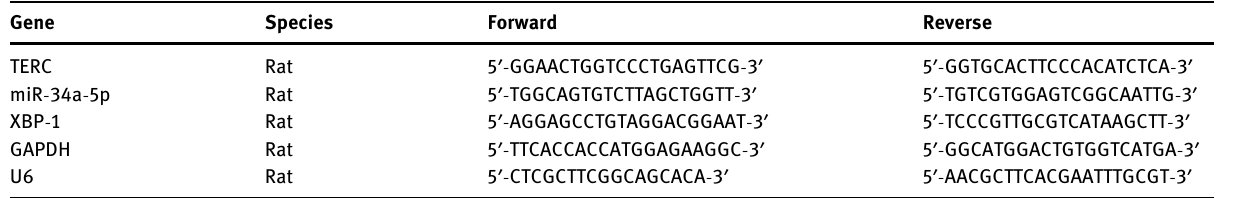
Table 1: Primers used in quantitative reverse transcription polymerase chain reaction for related genes Gene